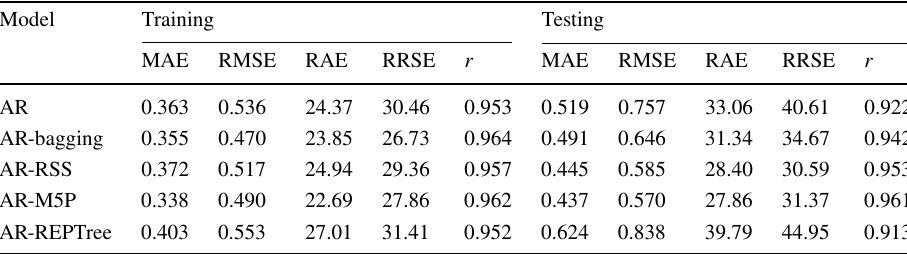
Table 7 RMSE, NSE, WI, and r for meta-heuristics algorithms-based models during the training and testing span at Islamabad station